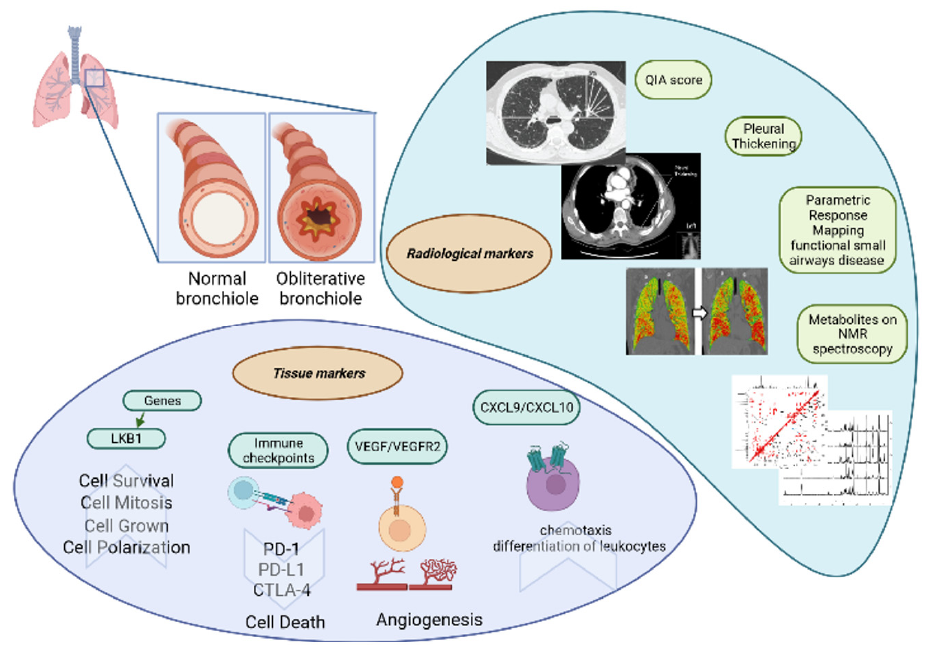
Figure 3. The radiological and tissue markers of BOS.